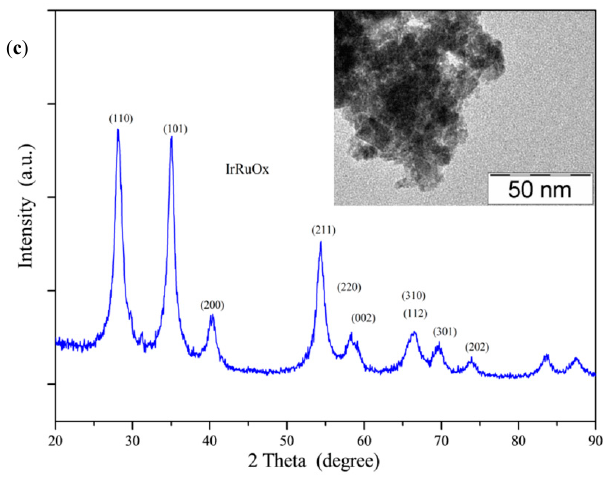
Figure 1. XRD tests and TEM images in the inset for ( a ) NiFeOx, ( b ) La 0.6 Sr 0.4 Fe 0.8 Co 0.2 (LSFCO) and ( c ) IrRuOx.